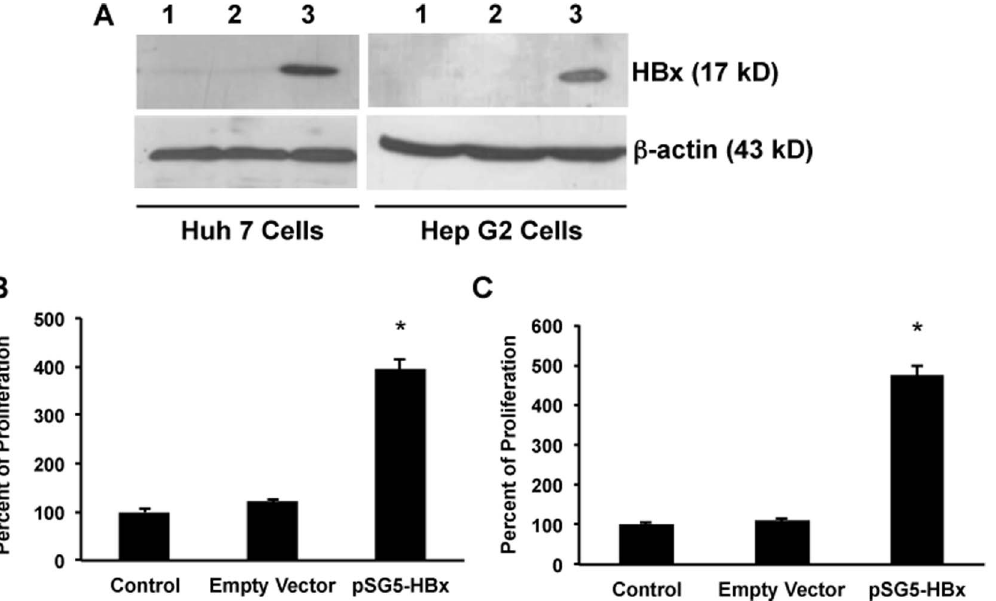
Figure 2. Effect of HBx on the proliferation. HBx protein was over-expressed in both Huh 7 and Hep G2 cells (A). HBx was over-expressed in hepatoma cells and the empty vector was used as transfection control. Lane 1, Control; lane 2, Empty vector; and lane 3, HBx transfected cells. Cell proliferation assay was performed using WST1 reagent in Huh 7 (B) and Hep G2 (C) cells. After 48 hours of transfection the proliferation assay was performed. (n=3; *p ,